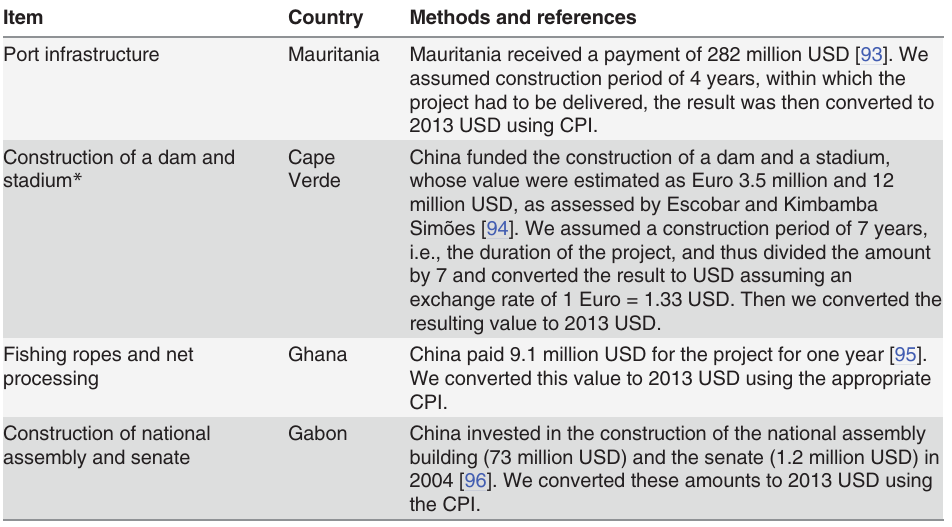
Table 2. Examples of computations of amount of Chinese payments to West African countries in exchange for fi shing access.